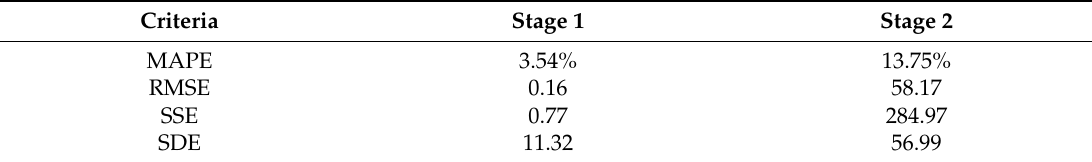
Table 4. Accuracy Analysis of the Proposed Method—Summer